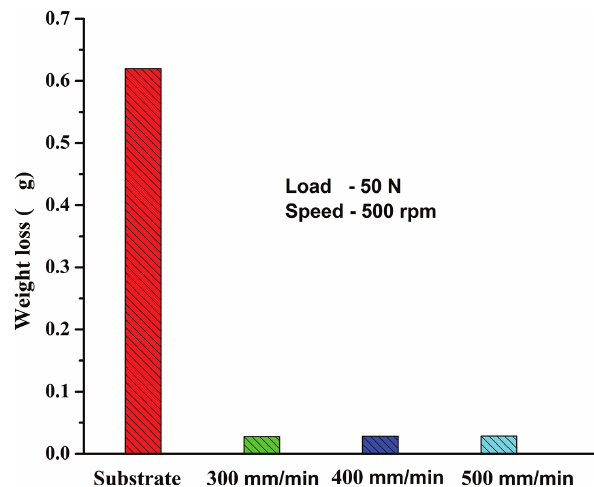
Figure 16: Effects of travel speed on weight loss.